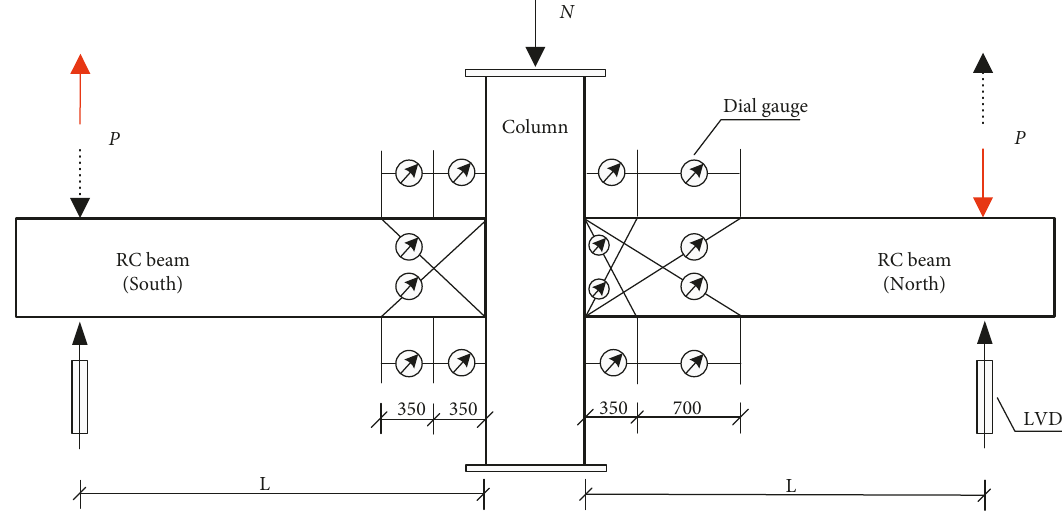
Figure 6: Installation positions of the dial gauges and linear variable differential transformers (LVDTs).